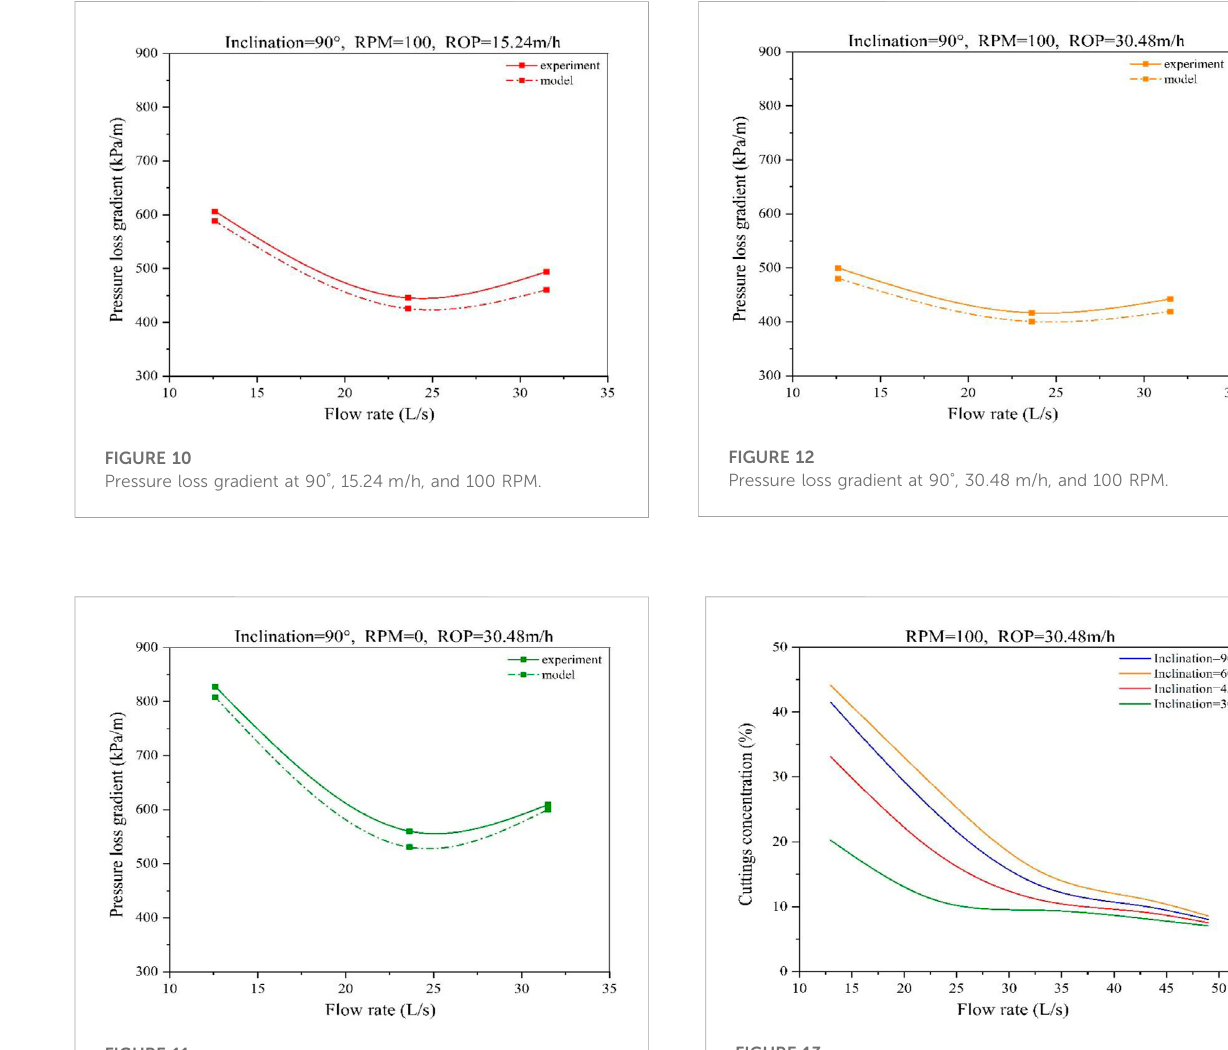
FIGURE 13 Effect of the inclination angle on the cuttings